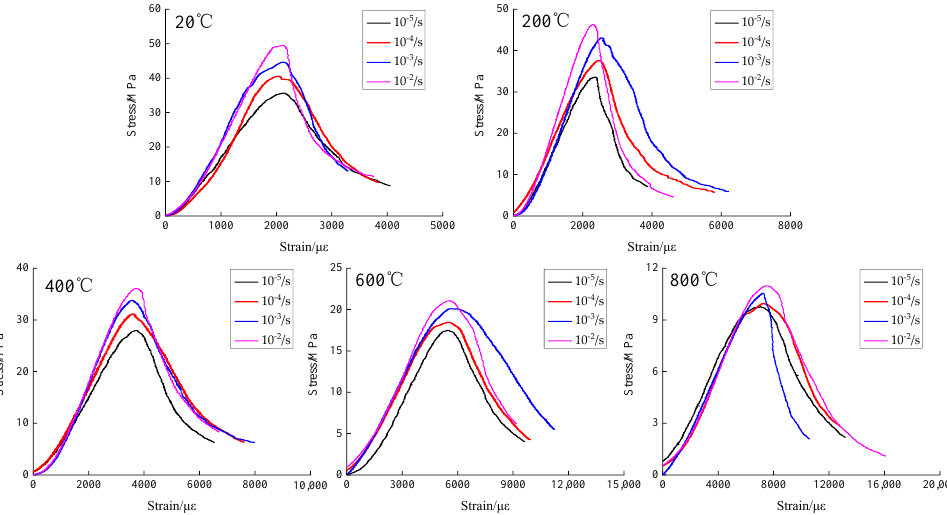
Figure 9. Compressive stress-strain curves of concrete under different temperatures and strain rates.